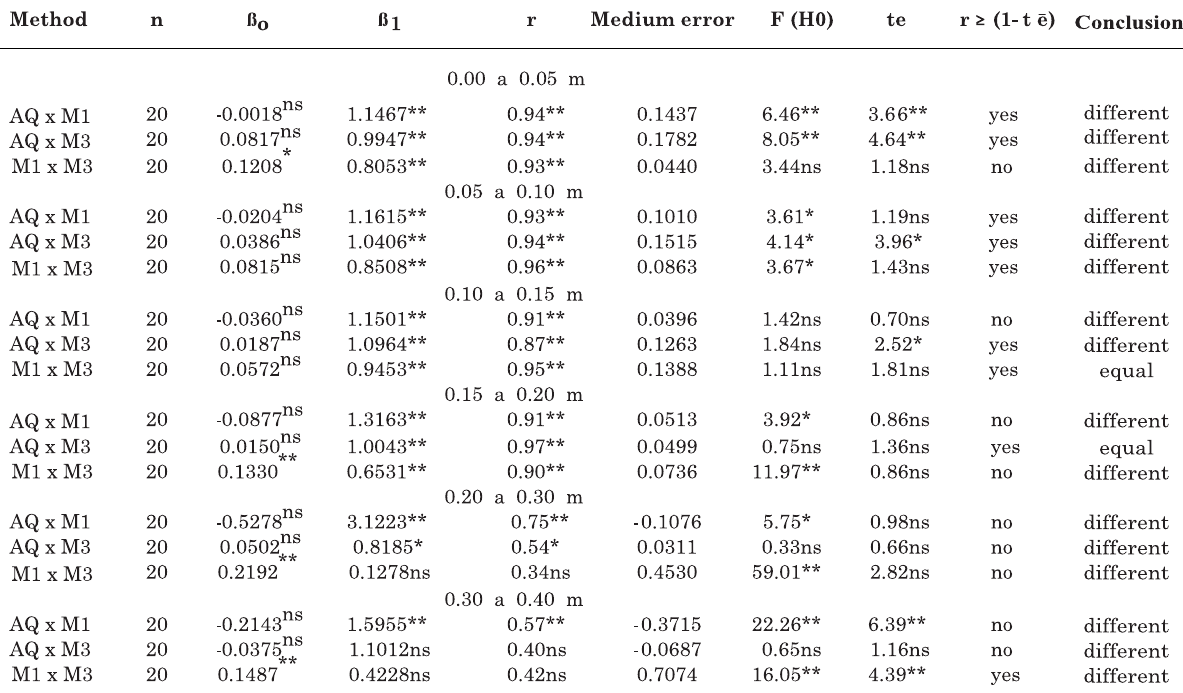
Table 3. Result of the identity test among extractors Hot Water, Mehlich-1 and Mehlich-3, in the different soil